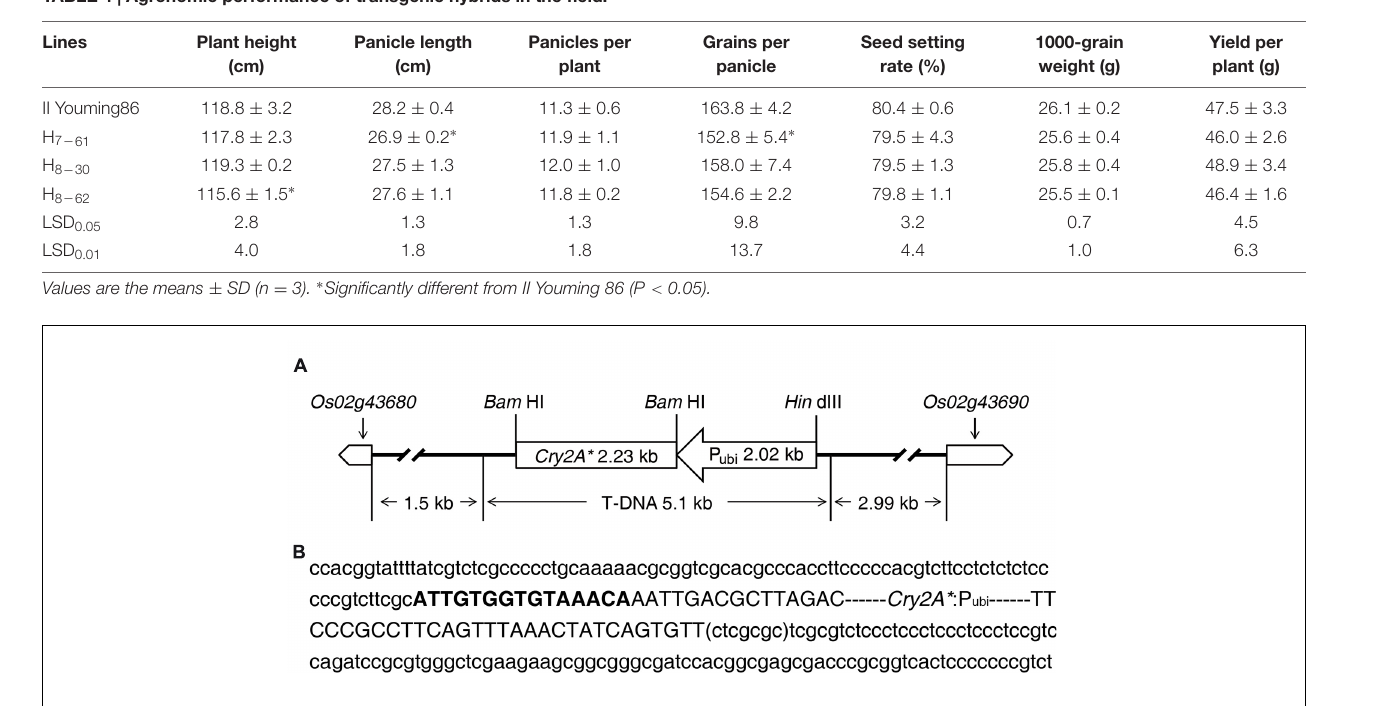
TABLE 4 | Agronomic performance of transgenic hybrids in the field. Lines Plant height